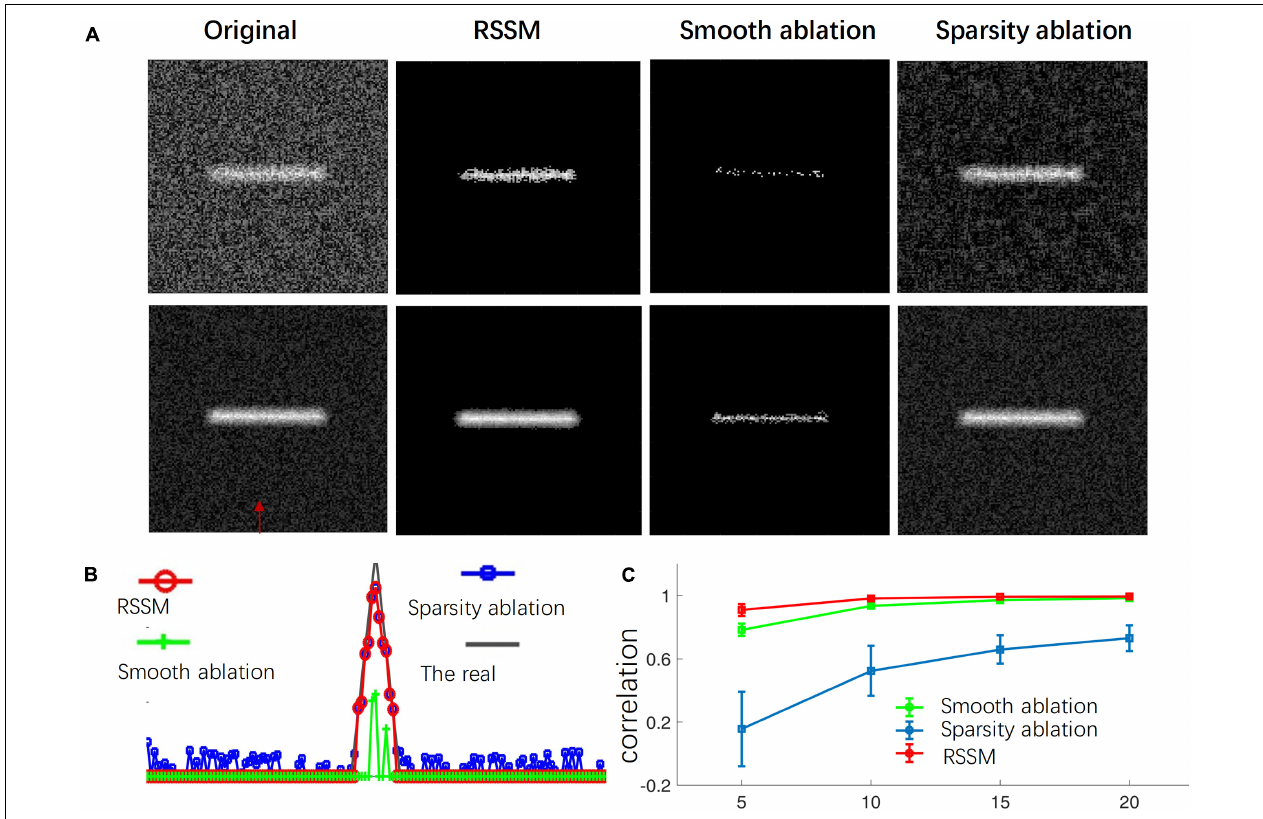
FIGURE 1 | Ablation study of the proposed RSSM method to validate the role of the sparse and smooth terms in foreground estimation. (A) Shows simulated neurite image (first column), estimated foreground via RSSM (second term), the smooth ablation model (third term), and the sparsity ablation model (fourth term). (B) Shows the image intensity distribution of the original image and the estimated foreground via three models along the direction that pointed out by a red arrow in (A) . The real means the image that only contains the foreground. (C) Shows the correlation between the image intensity distribution curves in (B) . The x -axis represents different groups of images and each group has the same foreground